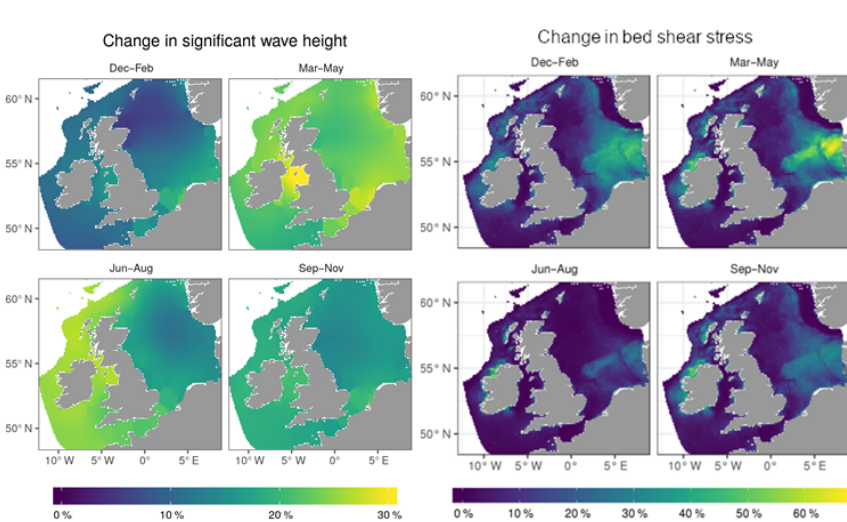
Figure 6. Left: changes in seasonal mean significant wave height over the 20th century. Right: changes in seasonal bed shear stress over the 20th century. Changes shown are between the climatological periods 1910–1929 and 1990–2009. Bed shear stress was calculated over the 20th century using the ERA20c wave reanalysis and present-day tidal conditions, with significant wave height calculated using the ERA20c reanalysis wave